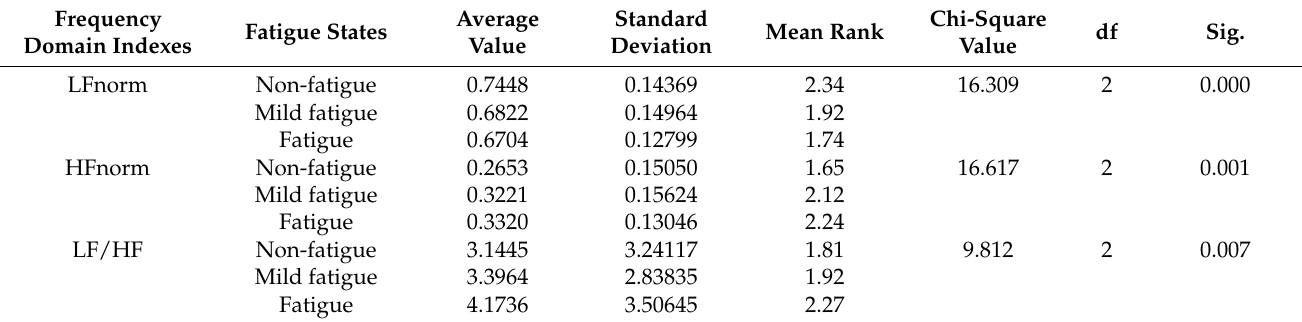
Table 8. Feature selection results of frequency domain indexes.